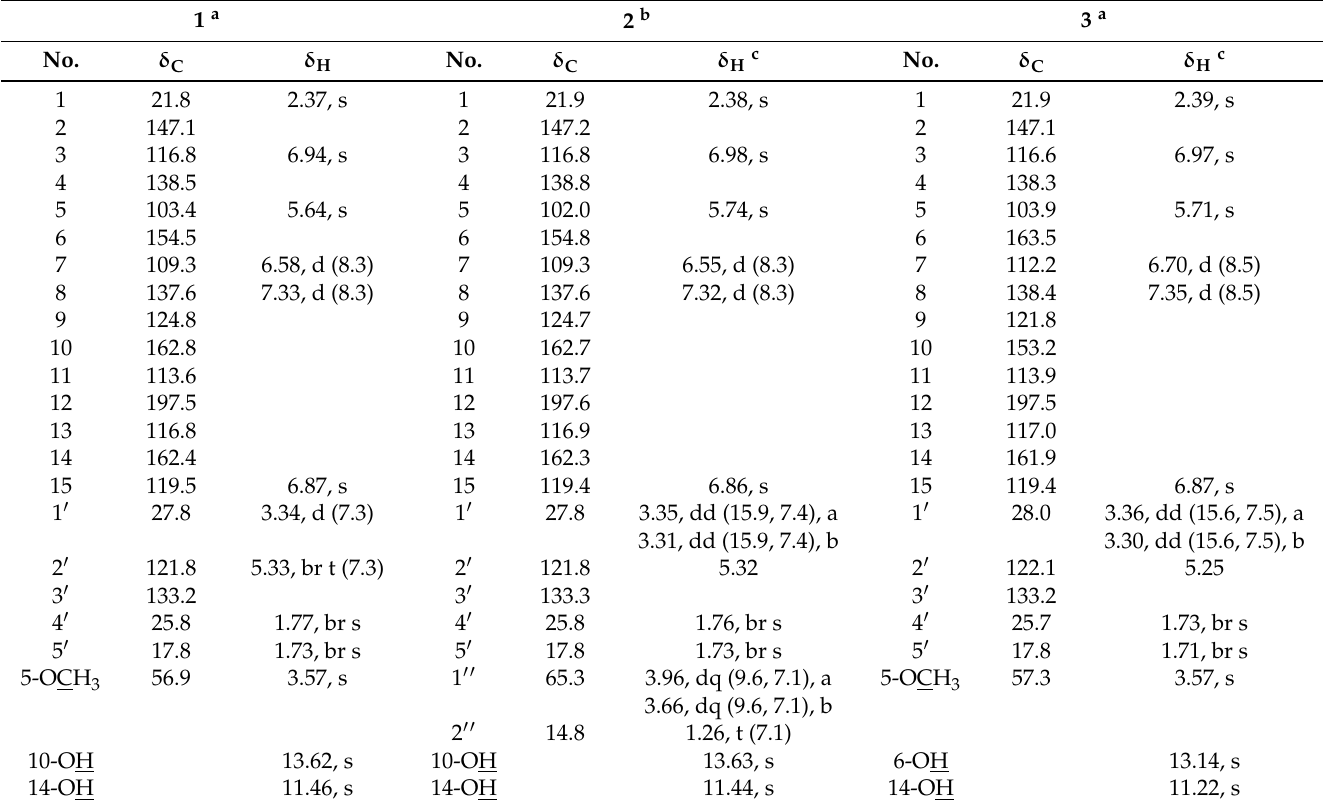
Table 1. The 13 C- and 1 H-NMR data of 1 – 3 ( δ in ppm, J in